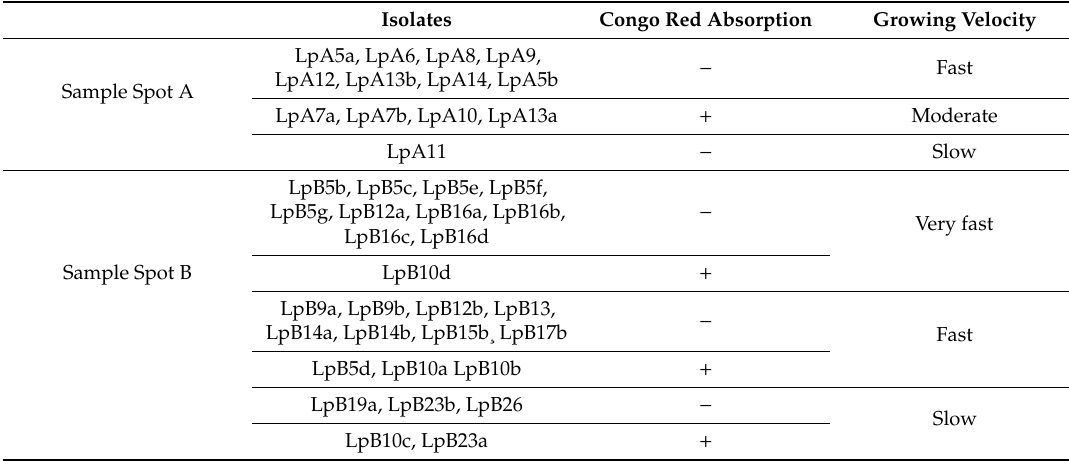
Table 2. Congo red absorption and growth speed of bacteria isolated from L. parviflorus nodules. Isolates Congo Red Absorption Growing